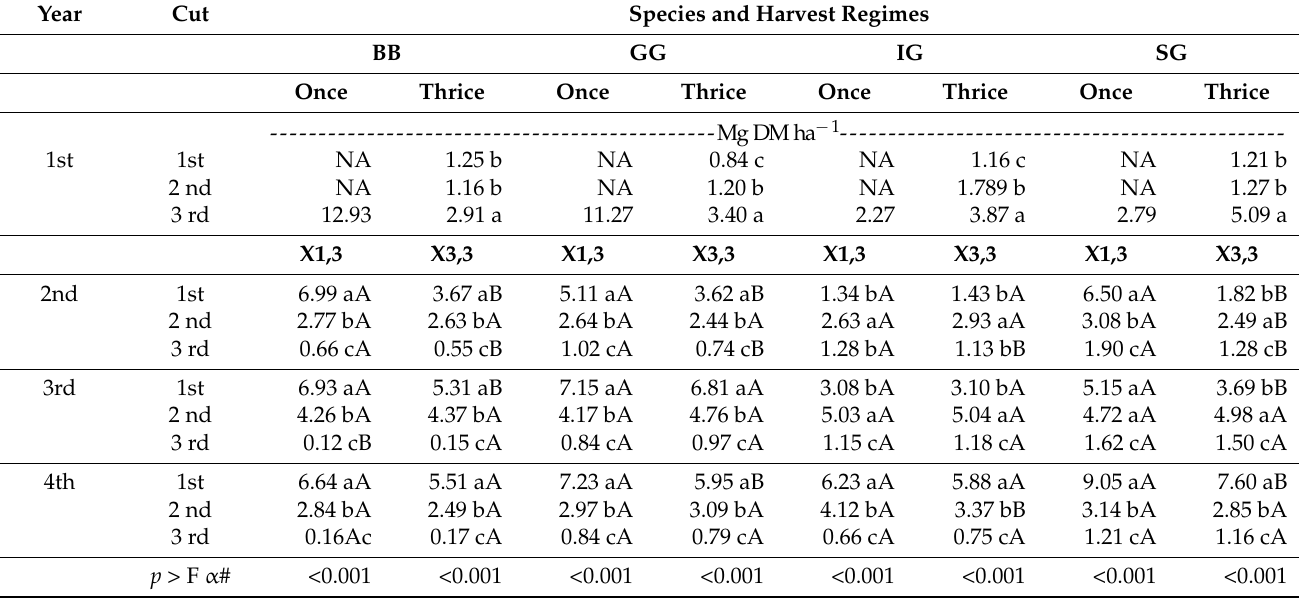
Table 5. Forage biomass at the first, second, and third harvest from newly established NWSG† stands harvested once or thrice during the first year (2014) and thereafter flipped to thrice year − 1 (X1,3) or continued the same (X3,3) for three more